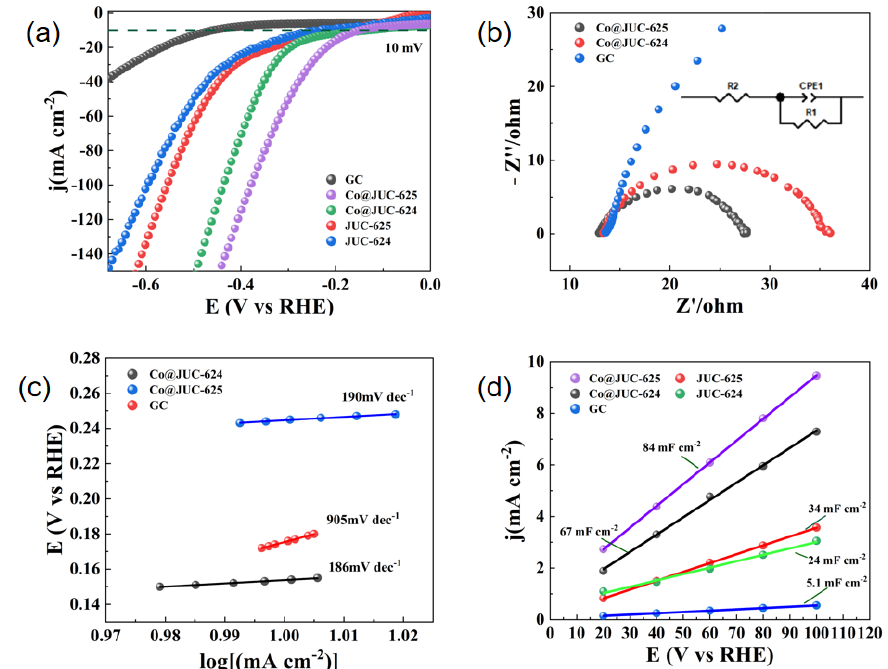
Figure 3. ( a ) LSV polarization curves of bare Control, CoNPs@JUC − 624, CoNPs@JUC − 625, JUC − 624 and JUC − 625 for HER in 1 M KOH (at a scan rate of 20 mV s –1 ); ( b ) EIS plots of Co NPs@JUC − 624, Co NPs@JUC − 625 for HER at a catalytically active potential of − 0.376 V vs. RHE with inset